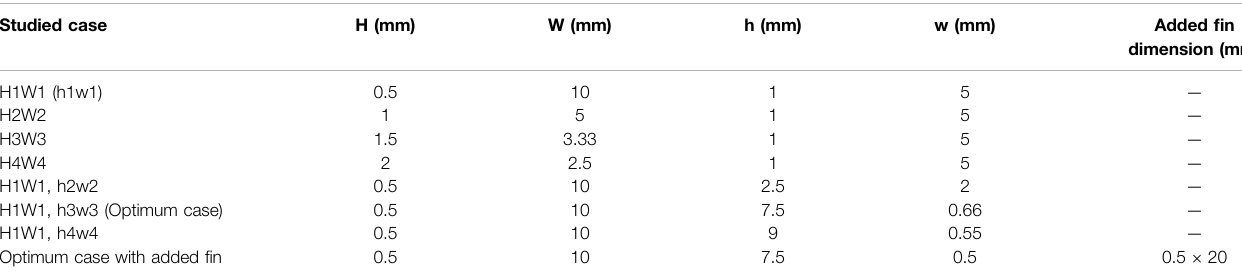
Optimum case with added fi